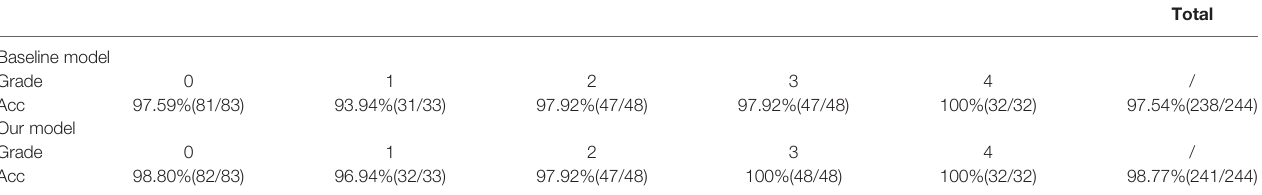
TABLE 3 | Slide-level accuracy results of different grades in internal testing set.